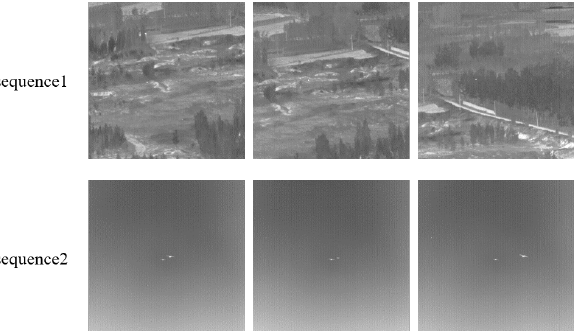
Figure 6. Examples of the published infrared image sequence dataset.